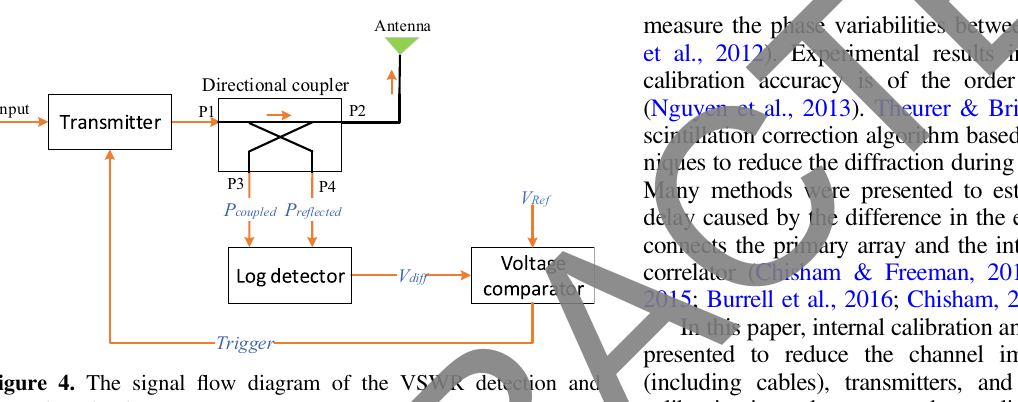
Figure 4. The signal fl ow diagram of the VSWR detection and protection